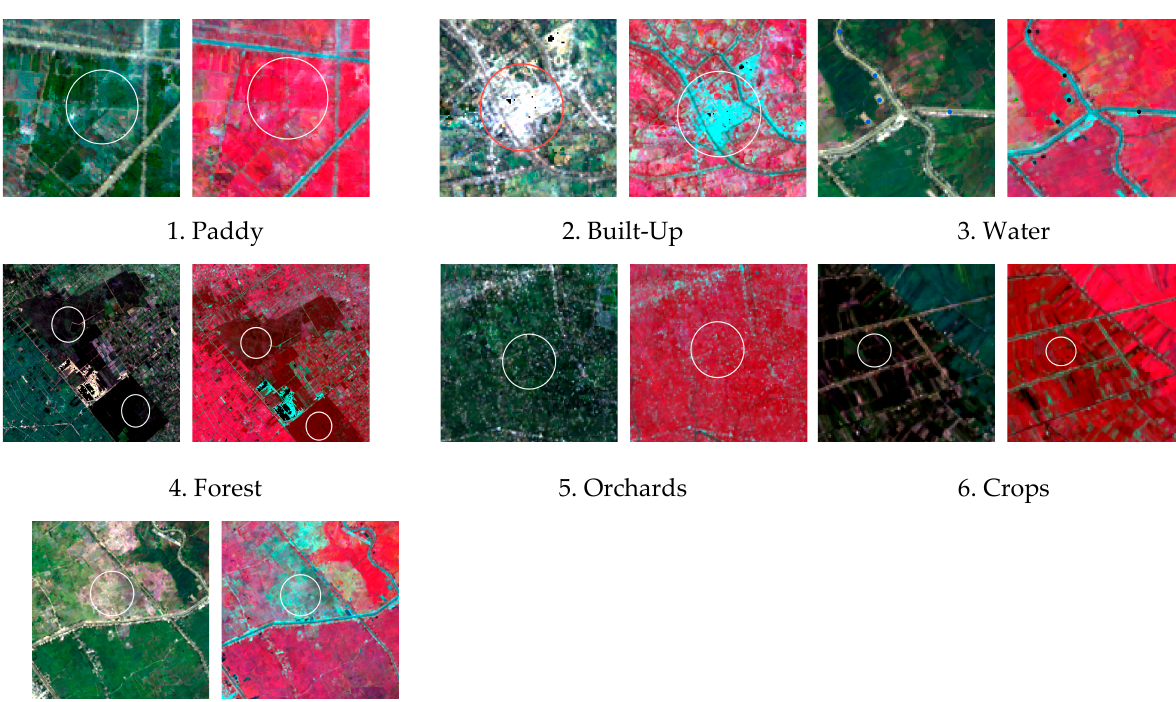
Figure 3. Samples were taken from the Landsat images of the Dong Thap Muoi area. For each class, the left image is the natural RGB band combination, while the right image is the false composite with the NIR band for red color, the red band for green color, and the green band for blue color.